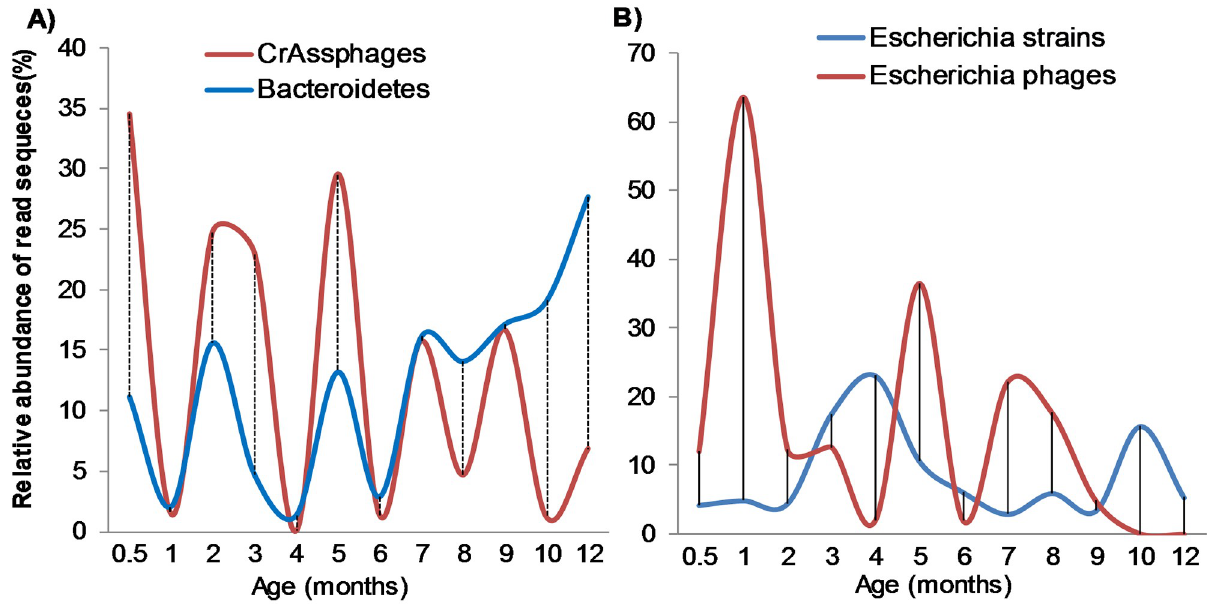
Fig 4. Average abundance of reads of the two most represented phages and their bacteria hosts in the infants, all year long. A) Lytic phage CrAssPhges and their Bacteroidetes hosts. B) Lytic Escherichia phages and their Escherichia bacteria hosts.